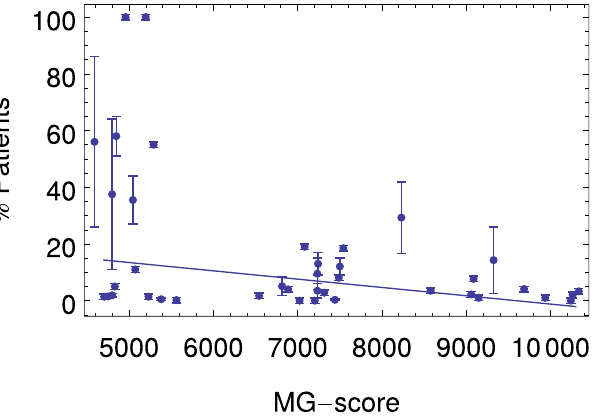
Figure 3. Scatter plot of the experimental immunogenicity and the MG score. The immunogenicity (% of patients that develop antibodies against the therapeutic antibody) is plotted versus the